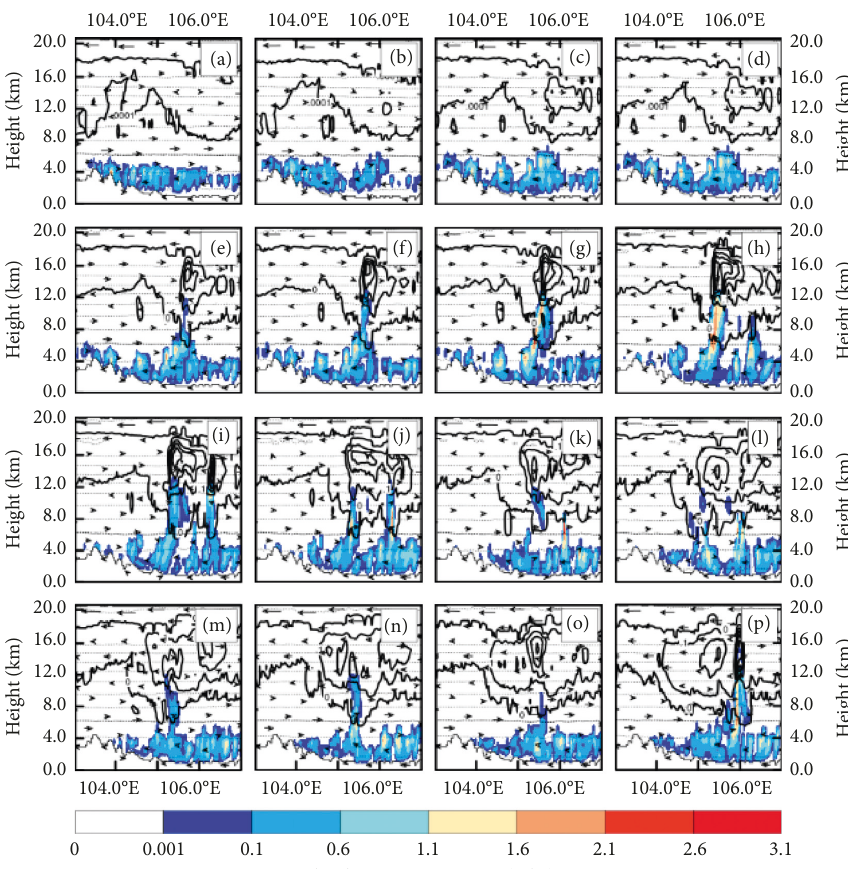
Figure 8: Longitude-height cross section of cloud droplet and ice crystal mixing ratio at 32.1 ° N; the mixing ratio of cloud droplets is represented by shade color; the mixing ratio of ice crystals is represented by solid lines (start value: 0.0001 g/kg; interval: 0.5 g/kg from 0.1 to 3.1 g/kg); the wind vector is represented by arrows; the thick dotted line is the 0 ° C isotherm on June 27: (a) 11:00; (b) 12:00; (c)